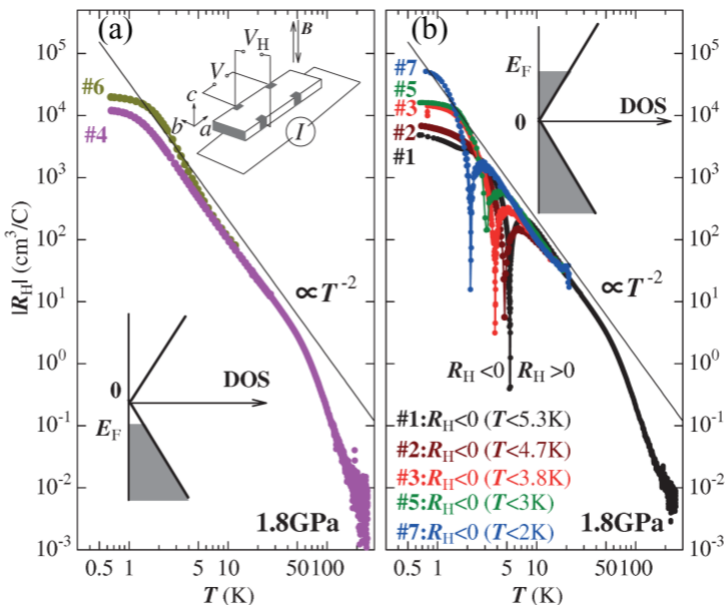
Figure 7. Experimental results of Hall coefficient, R , of α -(ET) temperature [82]. Note that R in electron-doped cases changes sign very sharply at some characteristic temperature which depends on samples, whereas the sign of R in hole-doped cases is